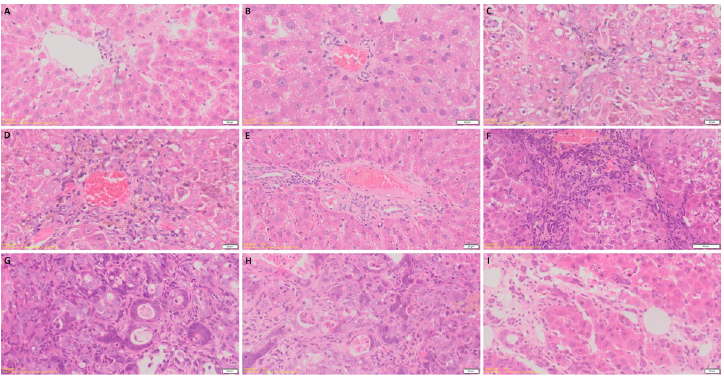
Fig 8. Hematoxylin-eosin staining of CCA model. (A) normal liver of rat, 40x. (B) rat liver after 8 weeks of feeding water containing TAA, 40x. (C) rat liver after 10 weeks of feeding water containing TAA, 40x. (D) rat liver after 12 weeks of feeding water containing TAA, 40x. (E) rat liver after 14 weeks of feeding water containing TAA, 40x. (F) rat liver after 15 weeks of feeding water containing TAA, 40x. (G) rat liver after 16 weeks of feeding water containing TAA, 40x. (H) rat liver after 17 weeks of feeding water containing TAA, 40x. (I) rat liver after 17 weeks of feeding water containing TAA (necrosis),